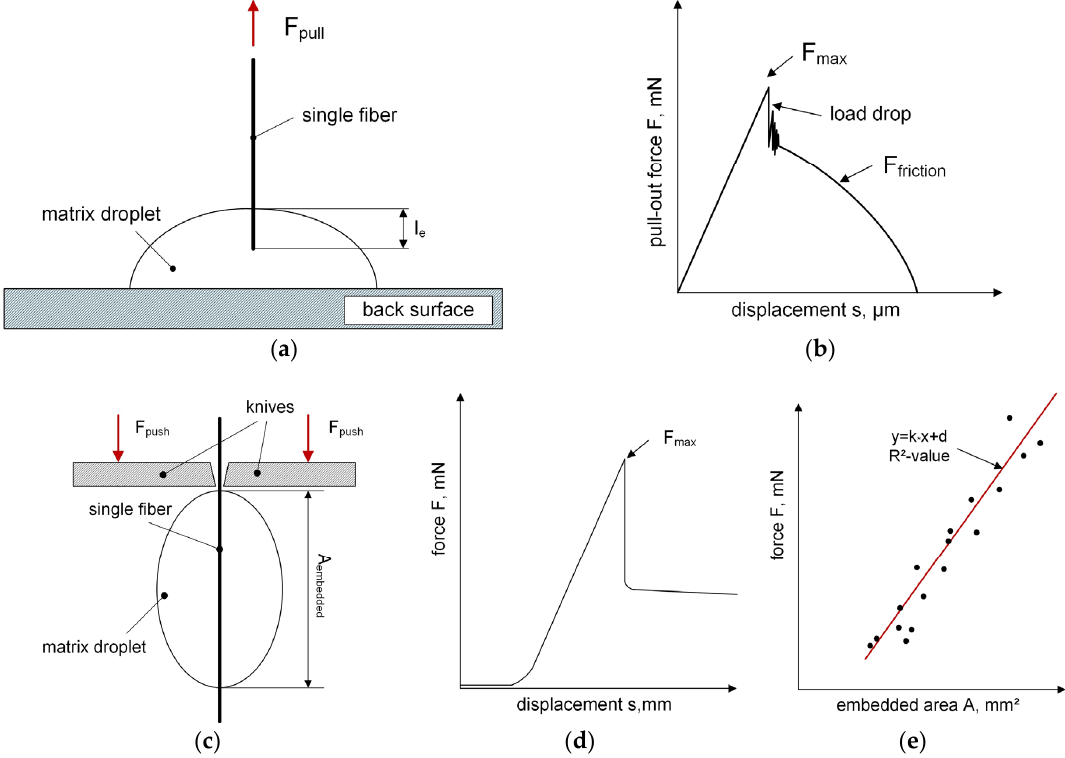
Figure 2. Schematic test procedure ( a ) and a typical force-displacement graph ( b ) of the SFPO test [13,22] with schematical test setup ( c ) and typical test graphs ( d , e ) of a microbond test [29,30].